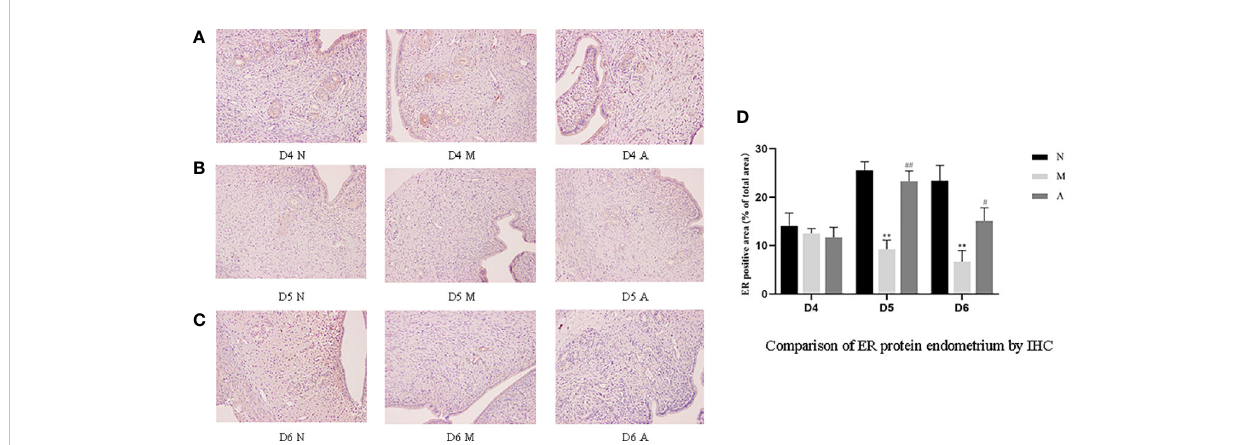
FIGURE 11 The expression of endometrial ER protein: (A) D4; (B) D5; (C) D6; and (D) comparison of ER protein by mean gray value (n=3). *or** represents that there is signi fi cant difference between M and N groups ( P < 0.05 or P < 0.01), #or ## represents that there is signi fi cant difference between A and M groups ( P < 0.05 or P < 0.01). Original magni fi cation *200. ER, Estrogen receptor; IHC, Immunohistochemistry; D, The embryo day; D4 N, D4 normal group; D4 M, D4 model group; D4 A, D4 acupuncture group; D5 N, D5 normal group; D5 M, D5 model group; D5 A, D5 acupuncture group; D6 N,